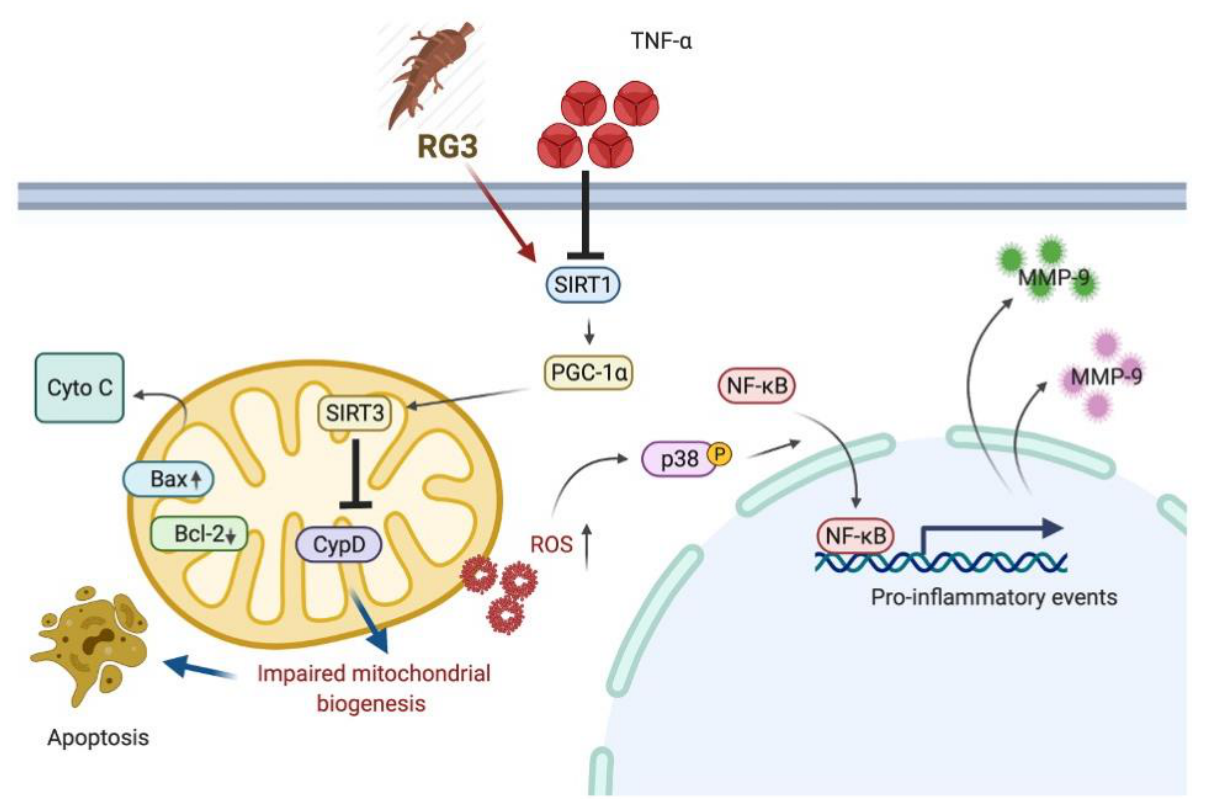
Figure 7. Proposed mechanisms of Rg3 in TNF- α -caused chondrocytes dysfunction. Rg3 activates SIRT1/PGC-1 α /SIRT3 pathway, thereby inhibiting the TNF- α -elicited acetylation of CypD. Rg3 improves mitochondrial biogenesis, downreg- ulates ROS, and apoptosis. Rg3 diminished the oxidative stress-associated p38 MAPK/NF κ Bp65 axis through upreg- ulation of SIRT1/PGC-1 α /SIRT3 signaling, leading to amelioration of IL-8 and MMP-9 secretion in chondrocytes with TNF- α